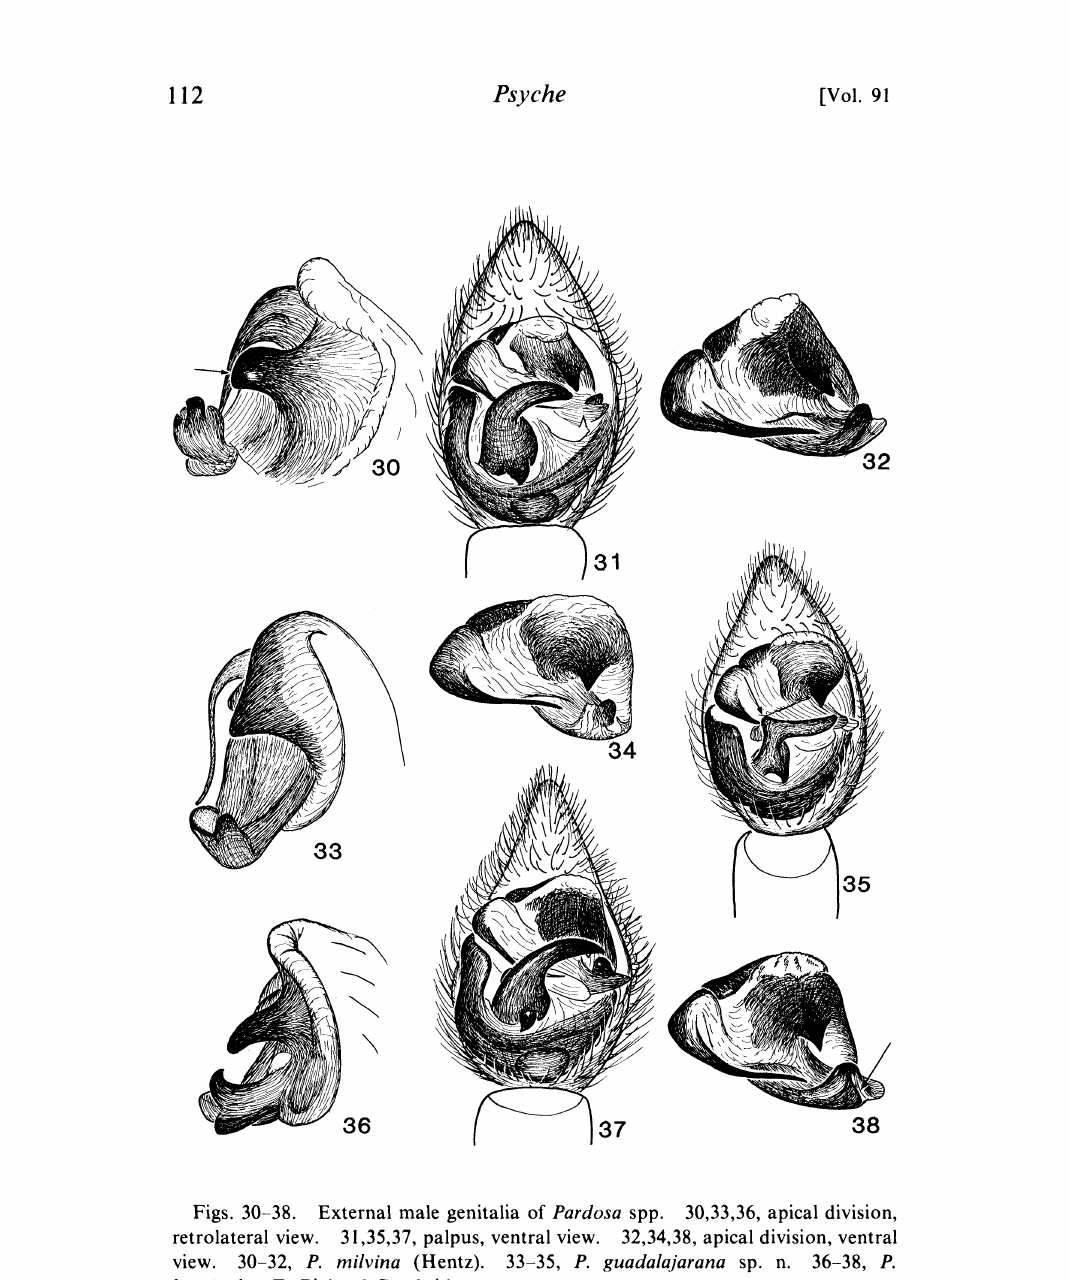
Figs. 30-38. External male genitalia of Pardosa spp. 30,33,36, apical division, retrolateral view. 31,35,37, palpus, ventral view. 32,34,38, apical division, ventral view. 30-32, P. milvina (Hentz). 33-35, P. guadalajarana sp. n. 36-38, P. longivulva F.